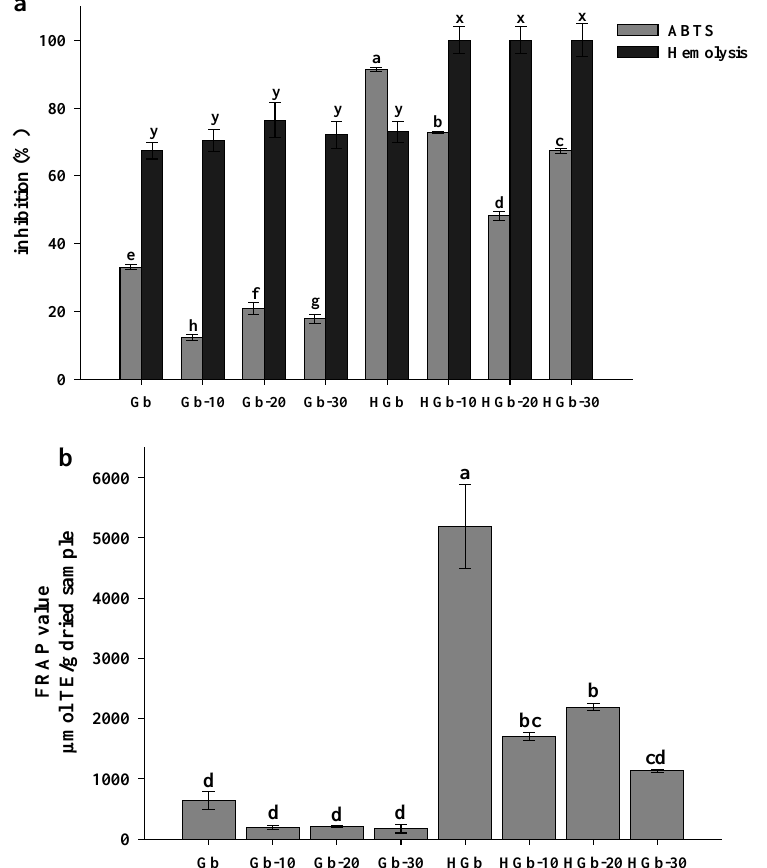
Figure 1. Antioxidant activity of globulin concentrates and hydrolysates pretreated with pulsed ultrasound. ( a ) ABTS and Hemolysis inhibition assays; ( b ) FRAP assay. Results are plotted as mean ± standard deviation of triplicate determinations. Different letters in the same parameter are significantly different ( p < 0.05). Concentrations of proteins and hydrolysates were 200 µg/mL. Gb = Globulin; HGb = Hydrolysate of globulin at 10, 20 and 30 min of ultrasound pretreatment.